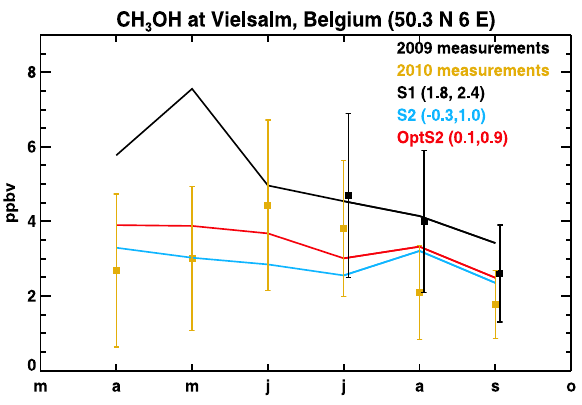
Fig. 10. Comparison between measured methanol concentrations near Vielsalm in Belgium (Table 5) and model results from the S1 (in black) and S2 (in blue) a priori simulations and from the OptS2 simulation (in red), see Table 1. Error bars correspond to the standard deviation. The average model/data bias and root mean square deviation are indicated inset in parentheses for each simulation.